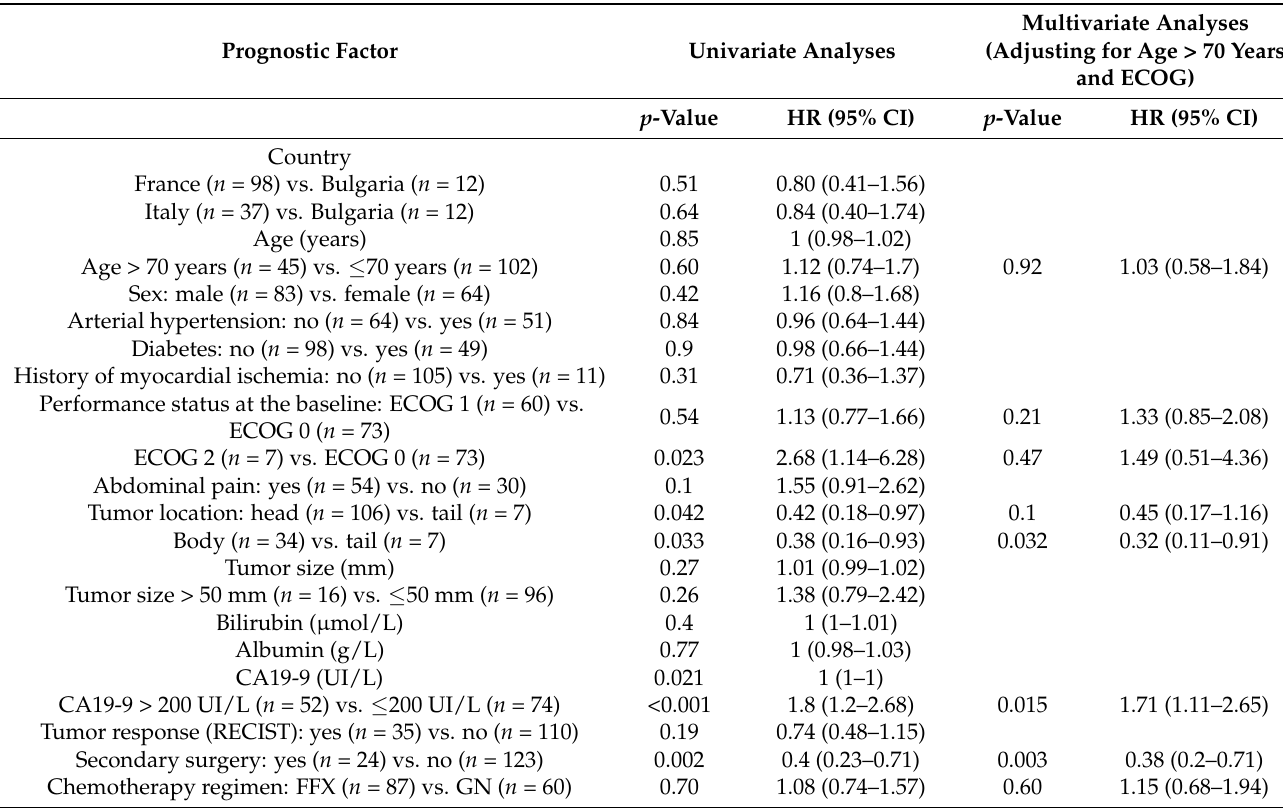
Table 4. Prognostic factors for overall